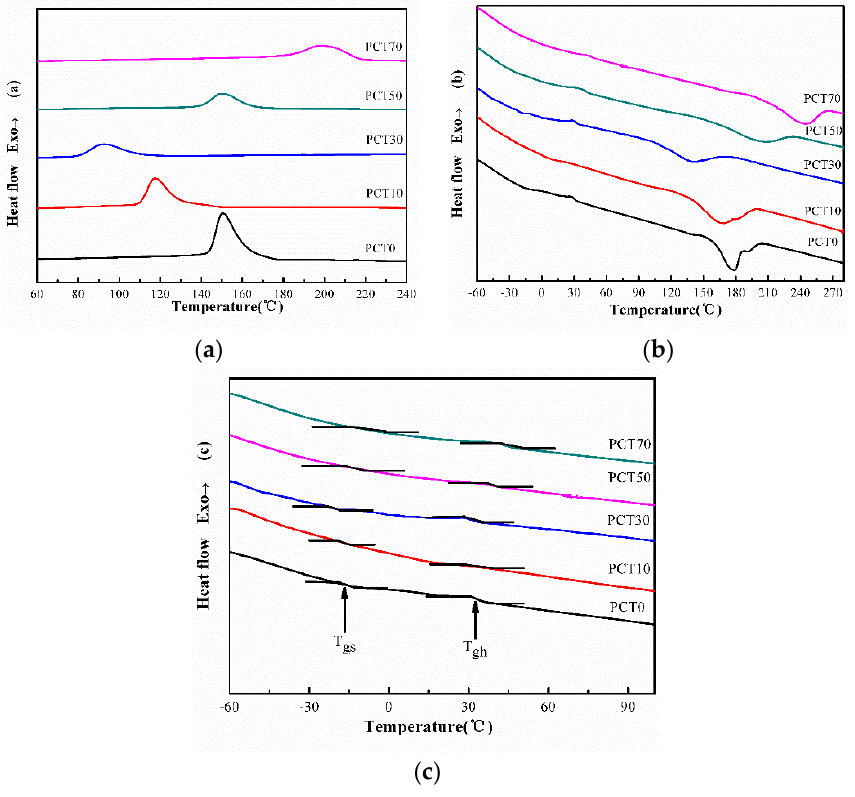
Figure 6. DSC traces of the (PBT-co-PCT)-b-PTMG copolymers at 10 °C min – 1 in nitrogen: ( a ) cooling traces; ( b ) heating traces; and ( c ) heating traces of the quenched samples.